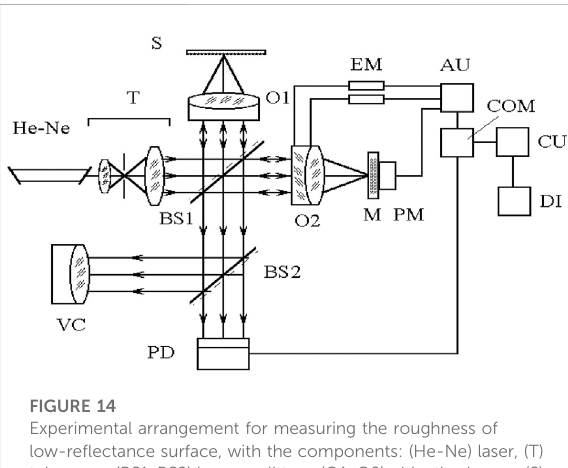
FIGURE 14 Experimental arrangement for measuring the roughness of low-re fl ectance surface, with the components: (He-Ne) laser, (T) telescope, (BS1, BS2) beam-splitters, (O1, O2) objective lenses, (S) sample, (M) mirror, (PM) piezoceramic modulator, (PD) 2×2 position-sensitive photodetector array, (VC) visualization channel, (EM) electric motors, (AU) automatic zero fringe adjustment unit, (COM) comparator, (CU) analogue calculation unit, (DI) digital